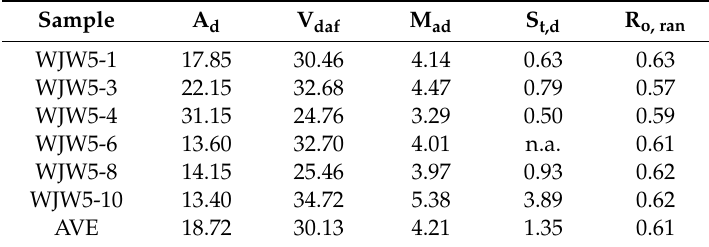
Table 1. Proximate analysis and the reflectance of the No. 5 coal seam from the Wujiawan mine. Sample A d V daf M ad